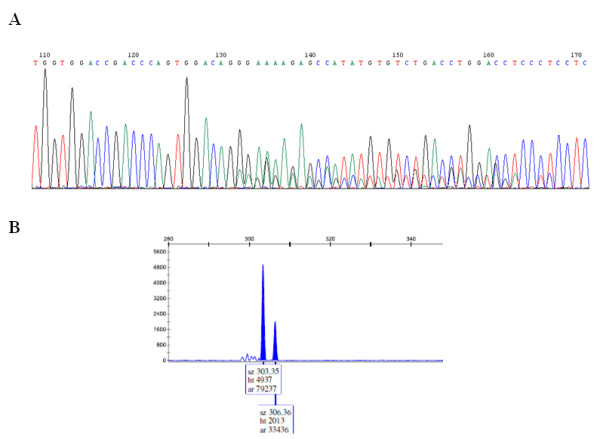
Example of the validation procedures employed. A: Electropherogram of the direct sequencing of a cDNA PCR product. Starting with the NAGNAG AS site at position 132 the two alternatively spliced sequence signatures are overlaid. B: FAM fluorescence intensity peaks of the two splice variants (length difference three nucleotides). The lower peak constitutes 40% of the area (ar) of the bigger one, i.e. an approximate ratio of 3:1.